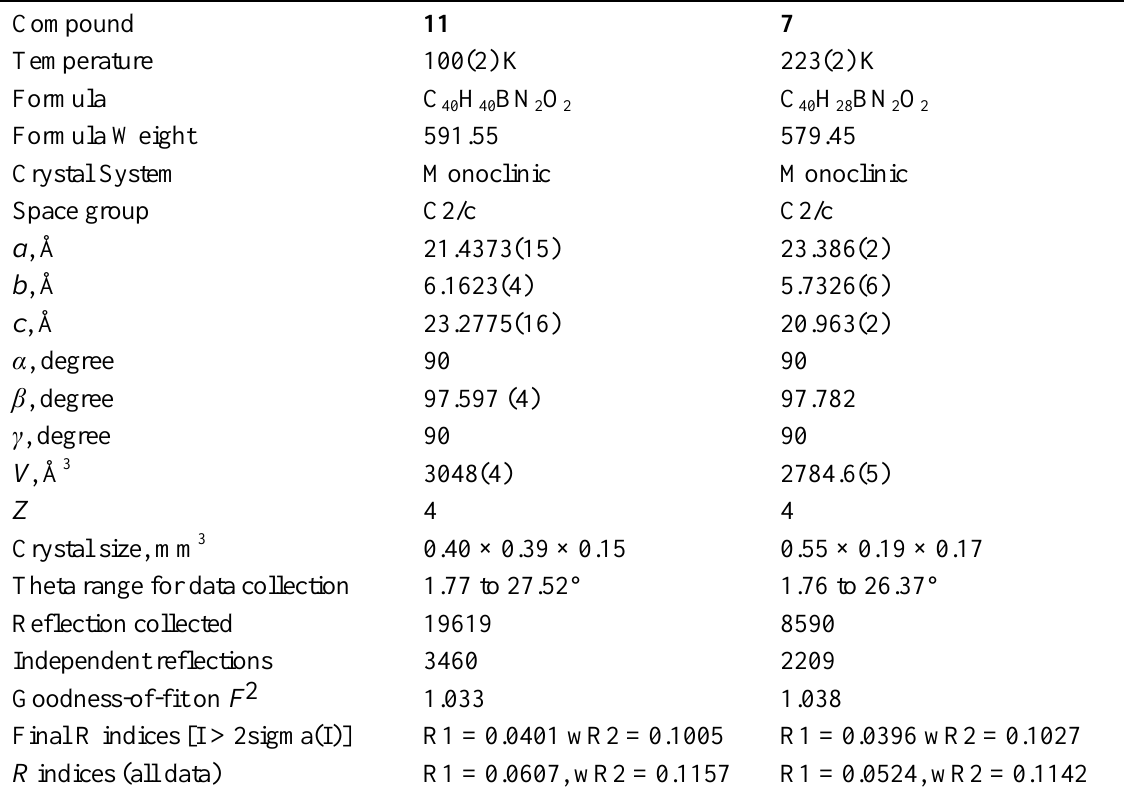
Table 1. Crystal data collection and refinement details for 11 and 7